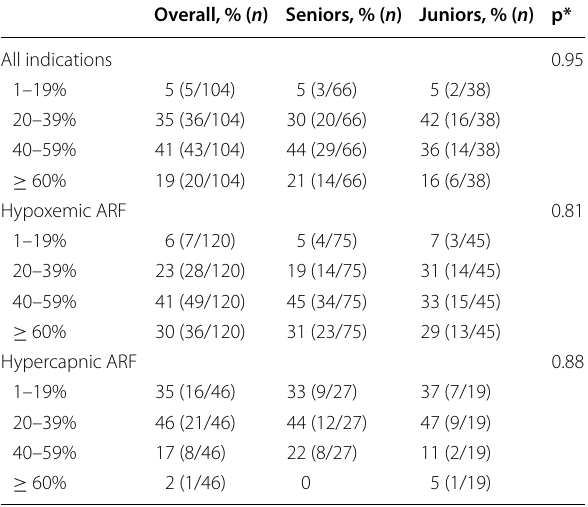
Table 2 Expected success rates of high-flow nasal cannula therapy in the different indications